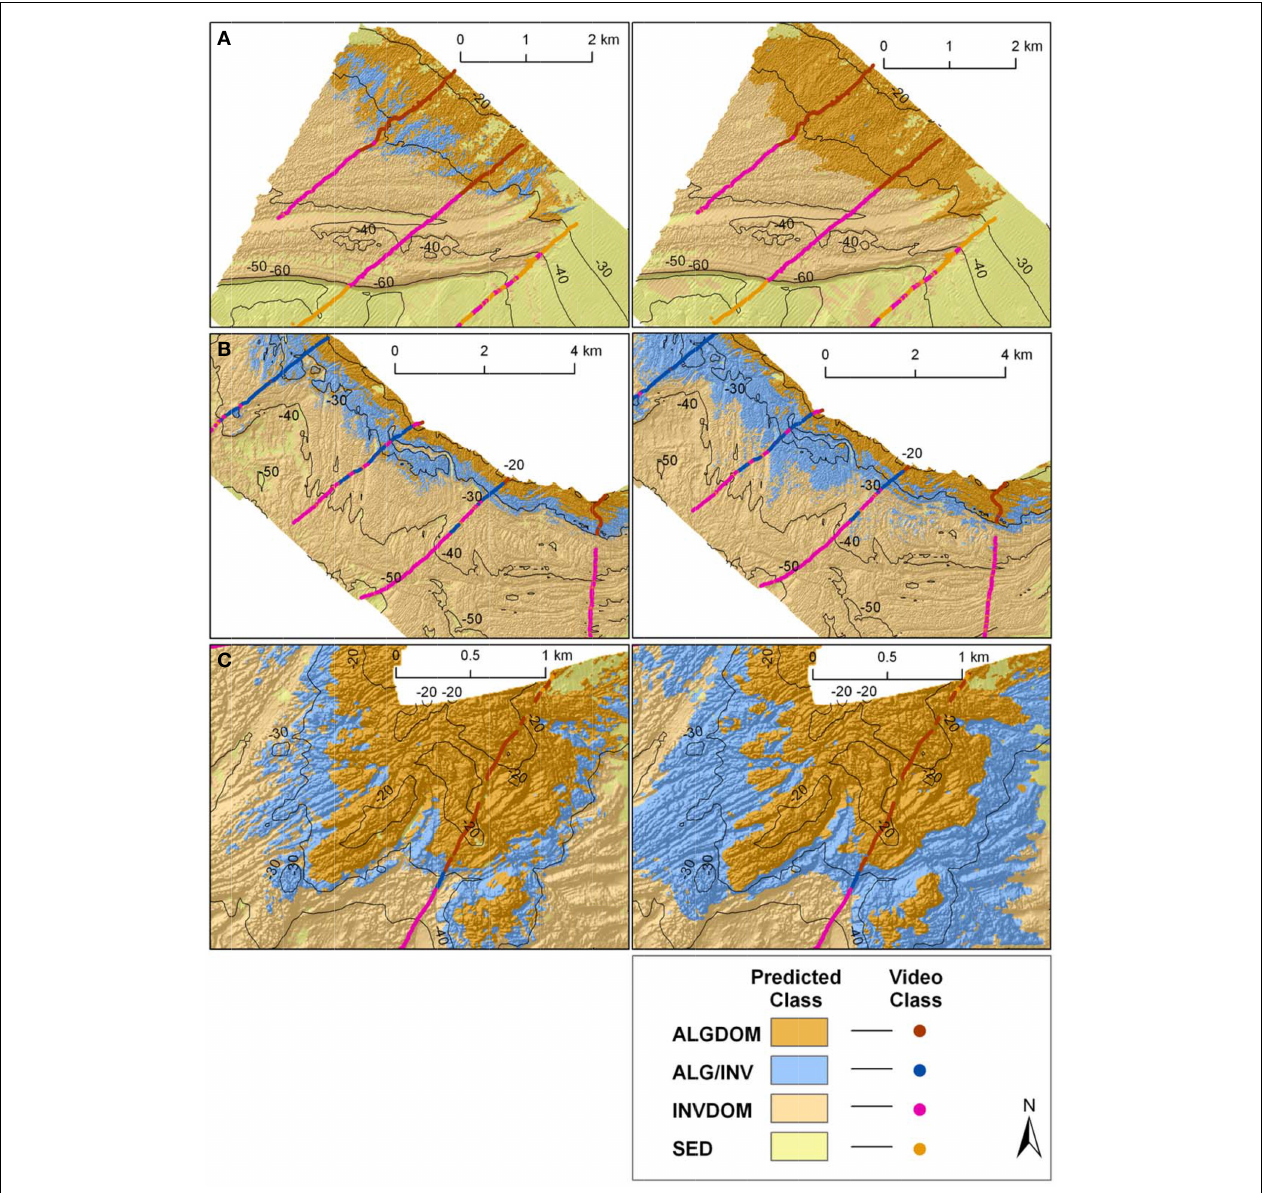
FIGURE 8 | Classified habitat maps of representative reef systems west of Cape Otway overlaid with classified observation data from towed video transects. Locations of reefs A, B and C are shown in Figures 1 , 4 .